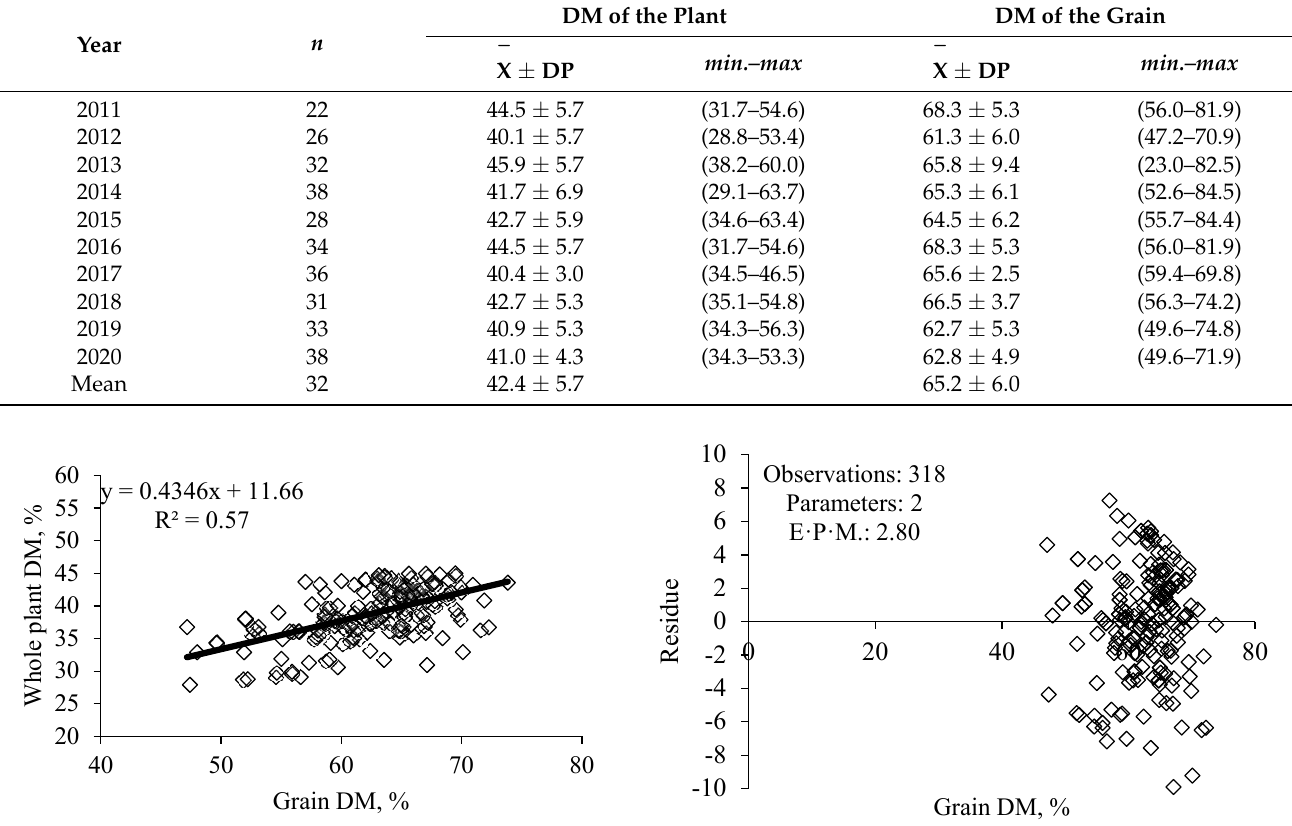
Table 5. Plant and grain DM content (mean ± SD) of corn plants at harvest time for silage production, cultivated in the state of Paran á , Brazil between the years 2011 and 2020.